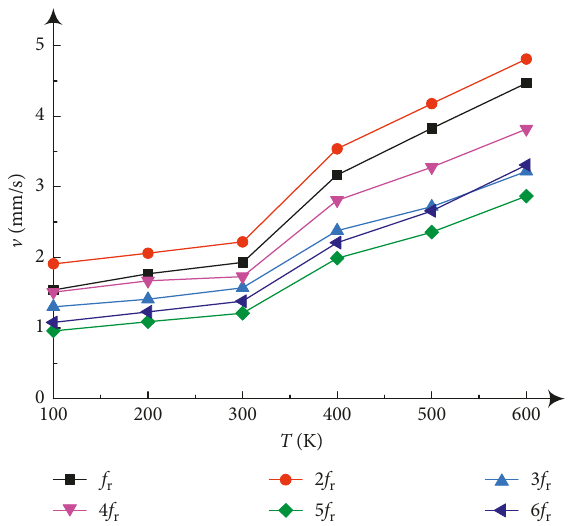
Figure 10: Trends of main frequency components at different temperatures.